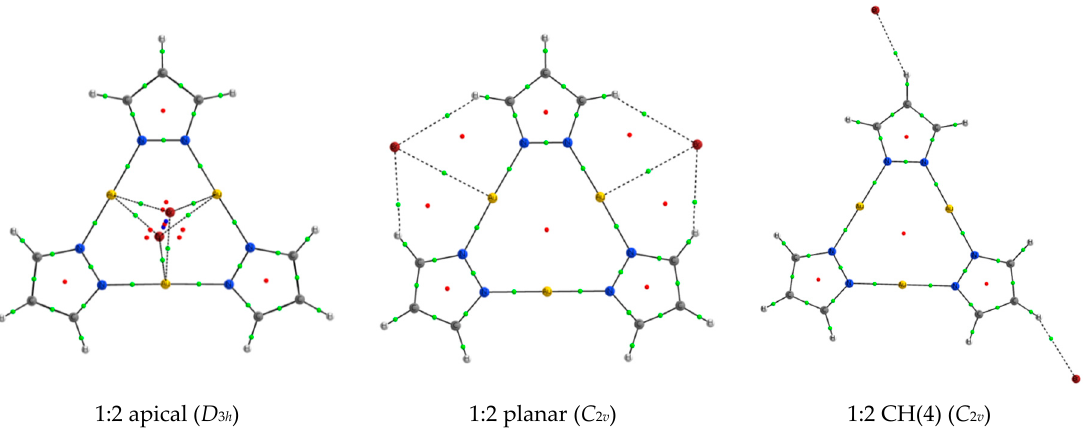
Figure 6. Molecular graph of the three minima located for the 1:2 (Pz-Au) 3 and Br − . The symmetry of each complex is indicated. Small green, red and blue dots indicate the position of the bond, ring and cage critical points, respectively.